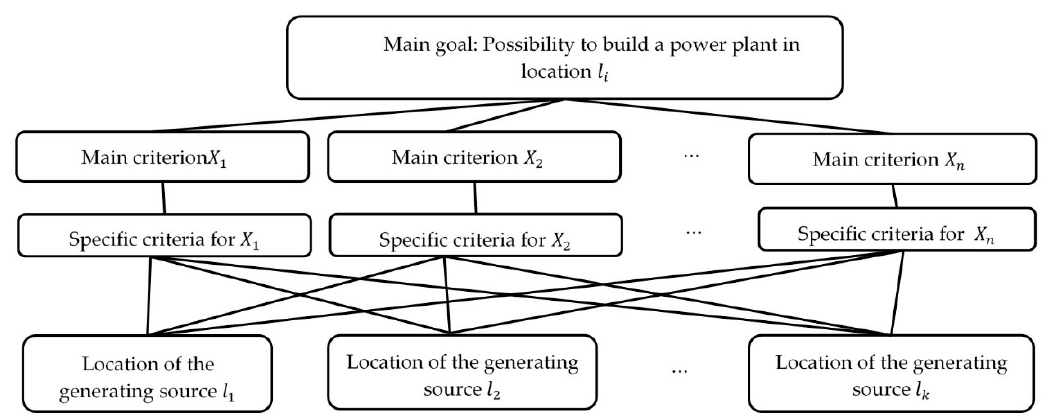
Figure 2. The hierarchical structure of the location problem in energy systems.